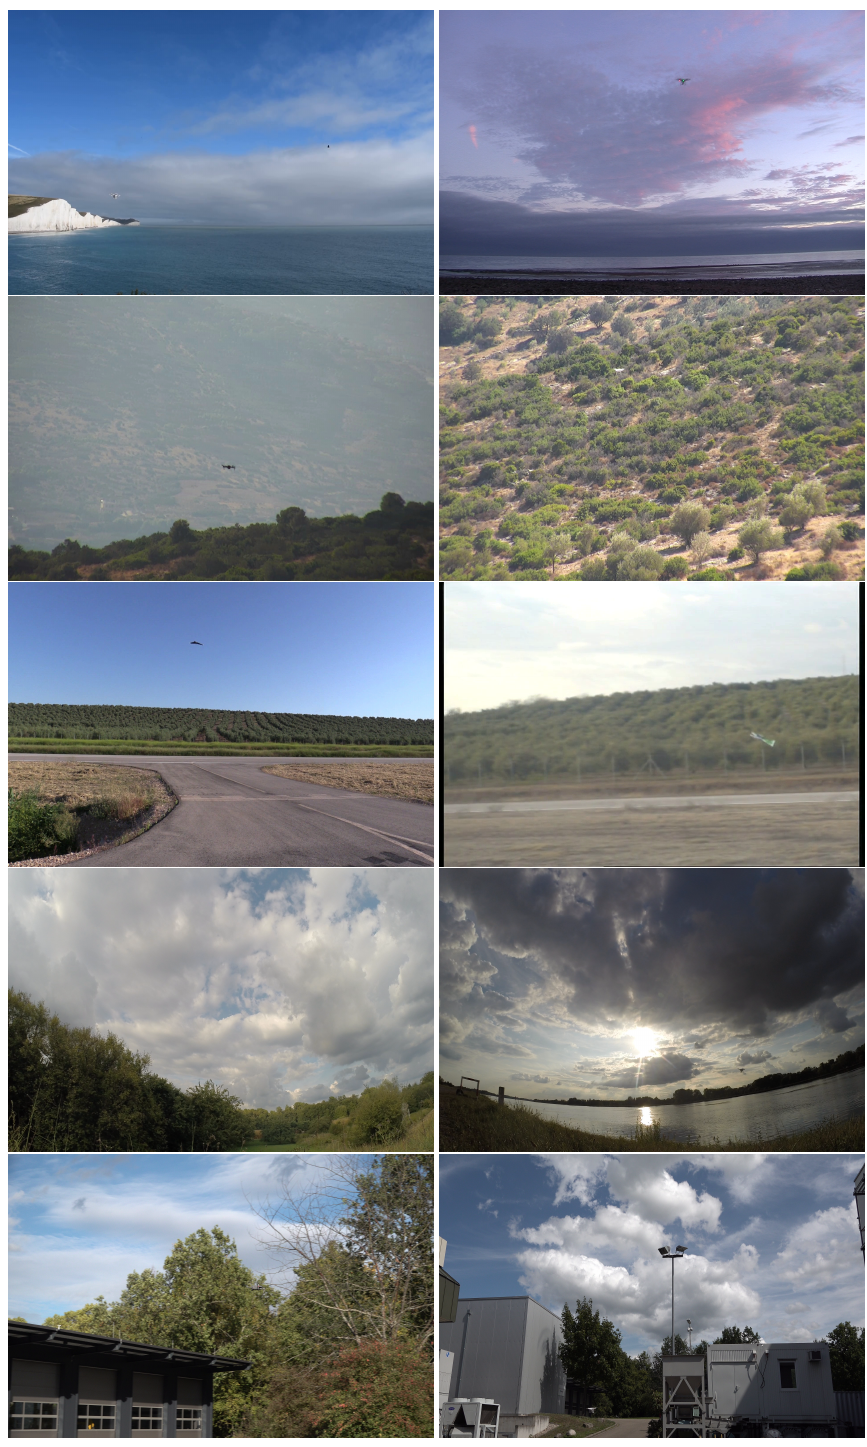
Figure 2. Sample frames extracted from the training videos exhibit the large variability of the